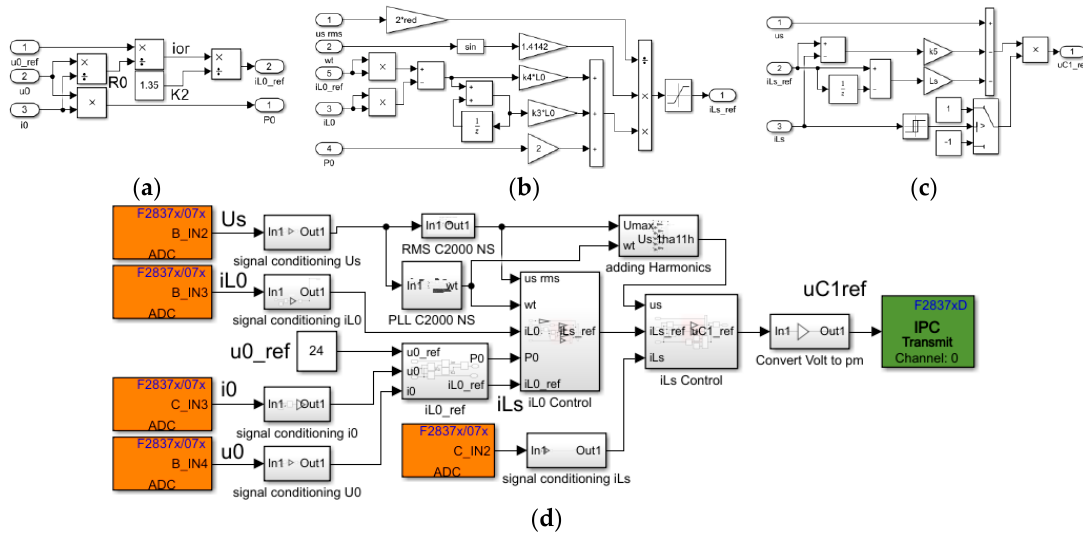
(cid:3045)(cid:3032)(cid:3033) ; ( b ) current ; ( b ) current controller (cid:3013) (cid:3116) L 0